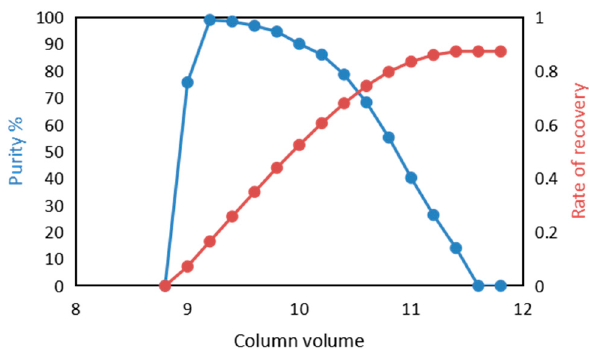
Figure 5. Relationship between product purity and recovery ratio in product elution process.